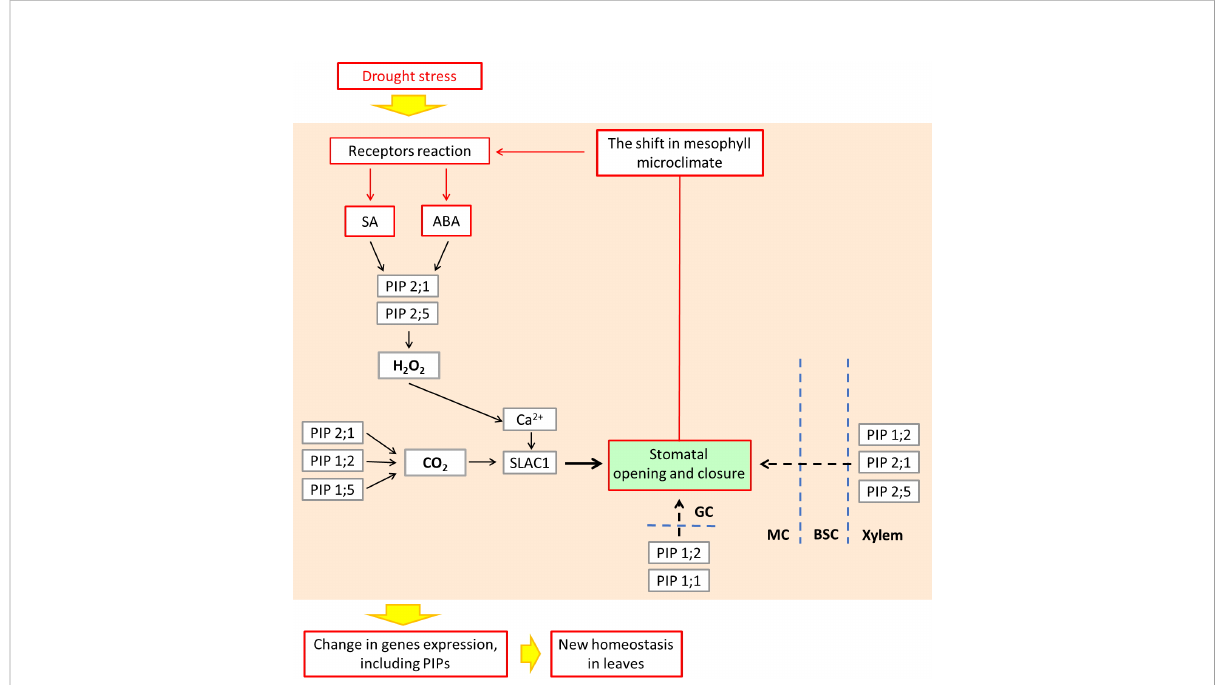
FIGURE 8 Acclimation to abiotic stress by cyclic regulation of stomata, involving hypothetical role of ABA, SA as the signaling molecules, and leaf PIP aquaporins, leading to microclimate stabilization within the leaf mesophyll. Conceptualized according to Joudoi et al. (2013) and Mittler and Blumwald (2015). ABA and SA control the expression and activity of PIPs which facilitate the movement of water across the membrane of guard cells (GC). In addition to water, aquaporins may also transport small molecules such as CO 2 and H 2 O 2 , depending on ABA and SA signaling. The maize PIP2;1 together with PIP1;2 and PIP 1;5 are known as the facilitators of CO 2 entry into GC causing stomatal closure (Ding et al., 2020). PIP2;1 and PIP2;5 also facilitate the ABA-triggered movement of H 2 O 2 that acts in guard cells as Ca 2+ channels regulator, leading to regulation of stomatal movement. Lastly, PIP1;2, PIP2;1 and PIP2;5 control the in fl ux of water from the xylem, through bundle sheath cells (BSC) to the mesophyll cells (MC) (Heinen et al., 2009; Yaaran and Moshelion, 2016), which completes the picture of aquaporins, maintaining the mesophyll microclimate. ABA, abscisic acid; SA, salicylic acid; SLAC1, slow anion channel; BSC, bundle sheath cells; GC, guard cells; MC, mesophyll